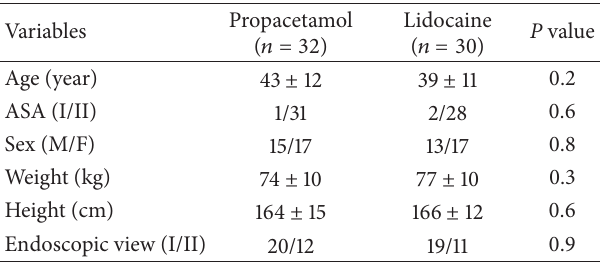
Table 1: Patients’ baseline data in each